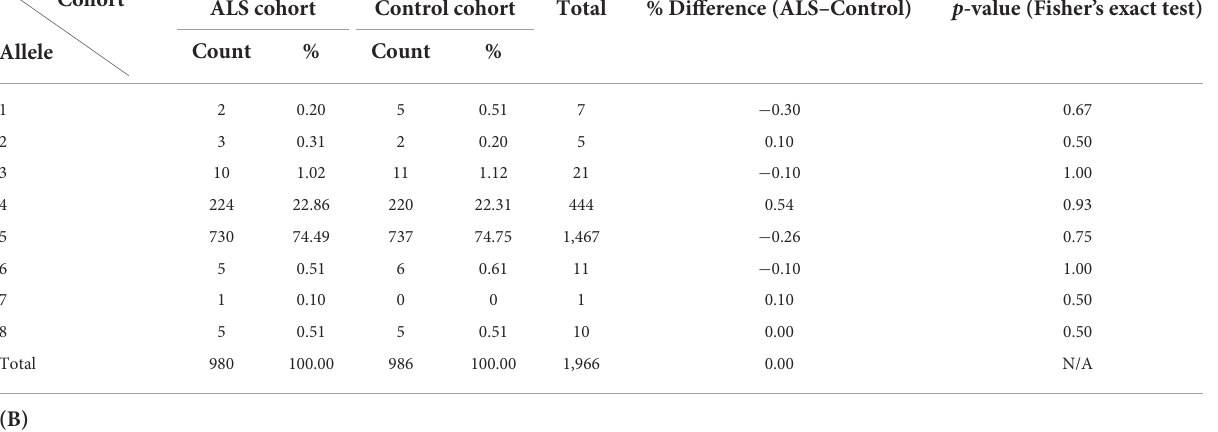
TABLE 1 Allele and genotype frequencies of CFAP410 VNTR in MNDA